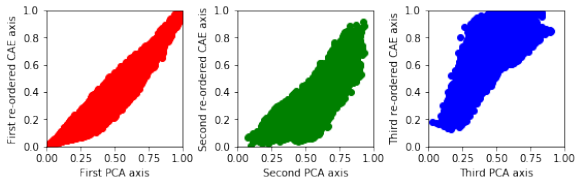
Figure 2. Scatter plot between each axes of PCA and CAE embeddings after selection of the best combination and